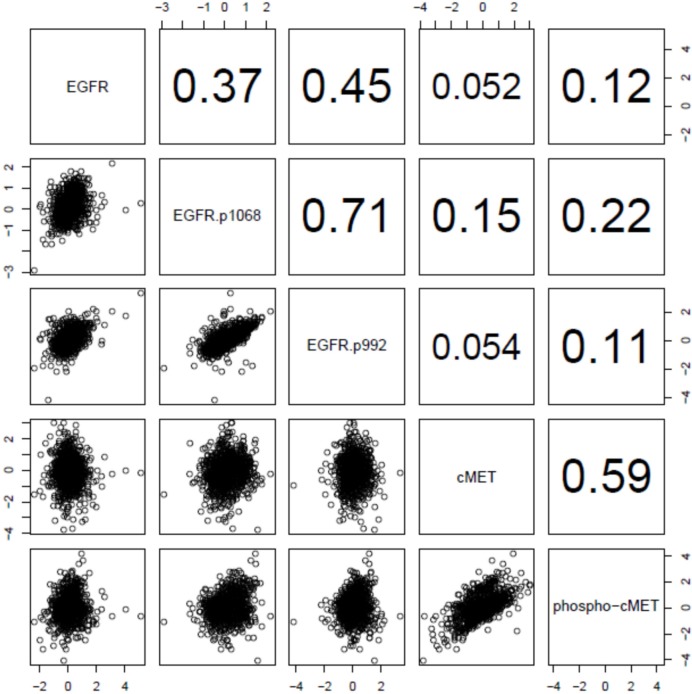
Pairwise scatter plot of EGFR and cMET and their phosphorylated forms in all breast cancers.The upper triangle shows the Spearman correlation coefficients between pairs of proteins.